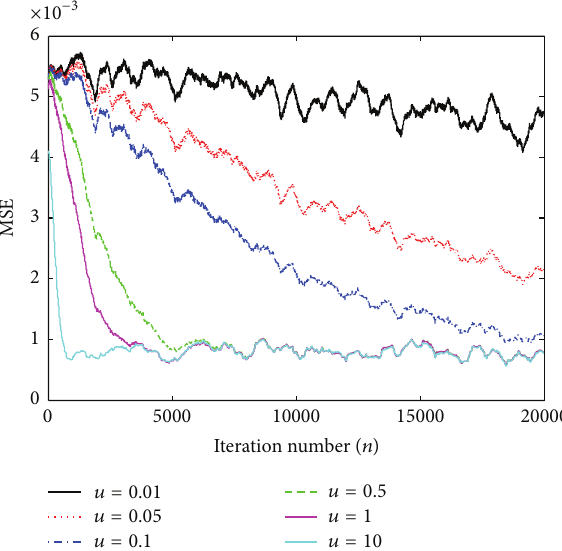
Figure 13: The MSE using the hybrid control under different step sizes.